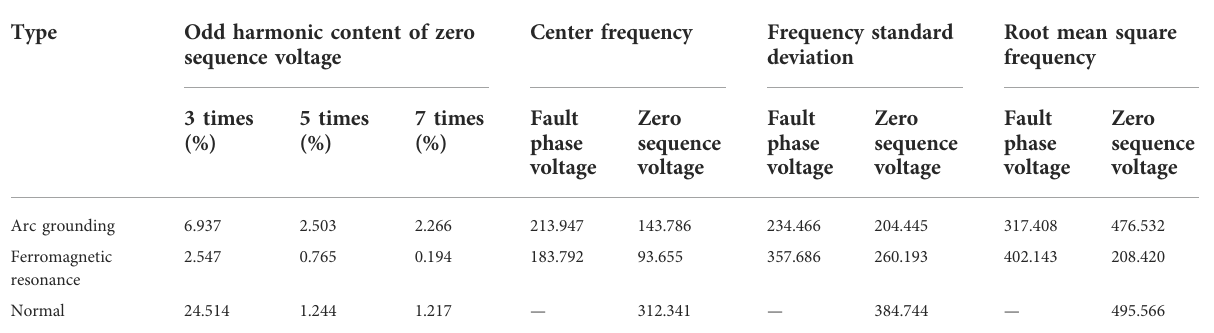
TABLE 2 Frequency domain waveform characteristics